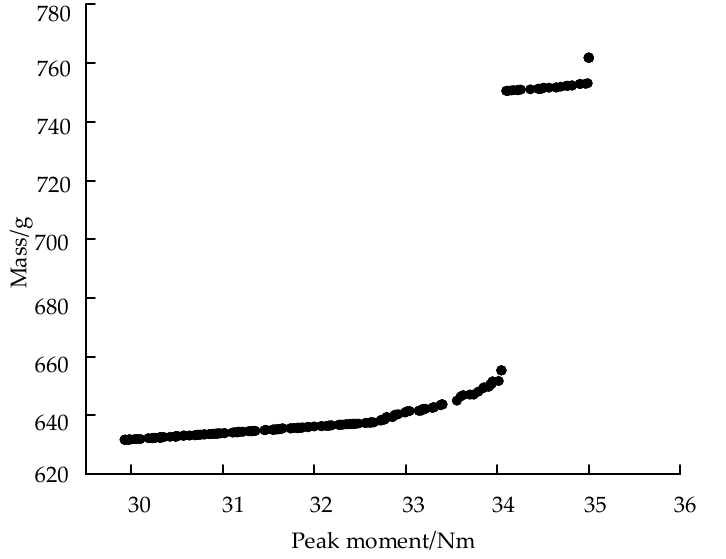
Figure 13. Pareto fronts of Mass and M peak for FLHD booms with S max ≤ 650 MPa.